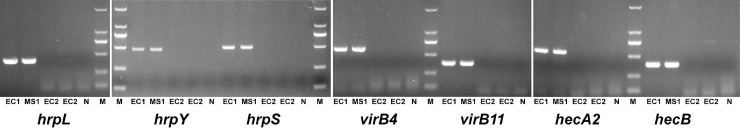
PCR detection of genes of T3SS, T4SS, and T5SS from D. zeae strains.hrpL, hrpY, and hrpS are genes of T3SS; virB4 and virB11 are genes of T4SS; hecA2 and hecB are genes of T5SS. Lane M indicates molecular weight markers from top to bottom (2,000, 1,000, 750, 500, 250, 100 bp); lane EC1 indicates D. zeae EC1 from rice; lane MS1 indicates D. zeae MS1 from banana; lane EC2 indicates D. zeae EC2 from rice; and lane N indicates ddH2O template.